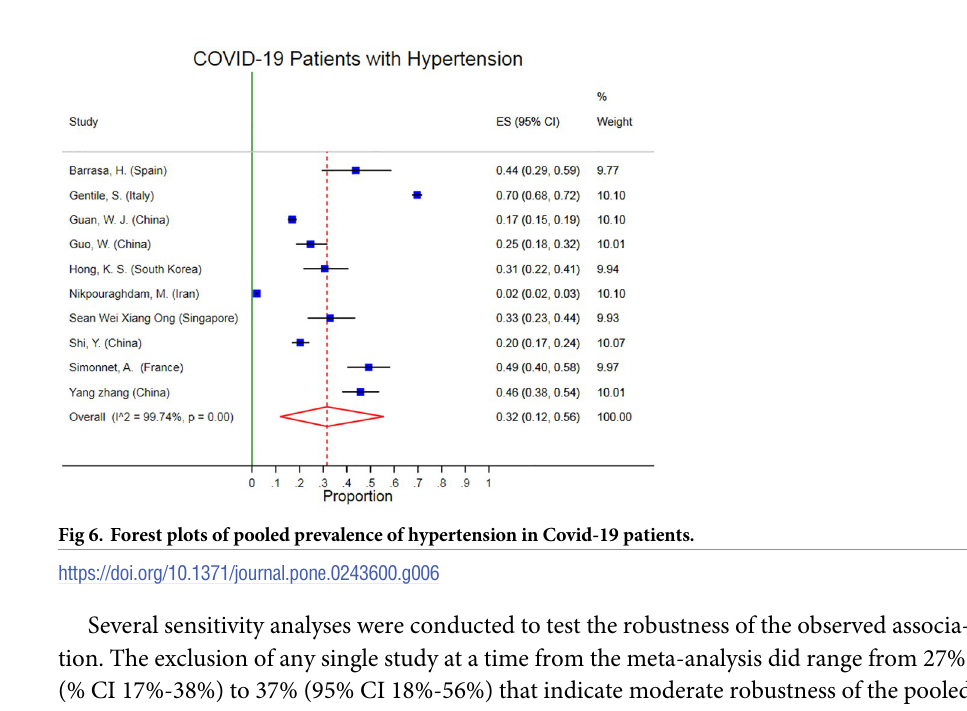
Fig 5. Forest plots of sensitivity analyses of each included study in meta-analysis of the prevalence of diabetes in Covid-19 patients.